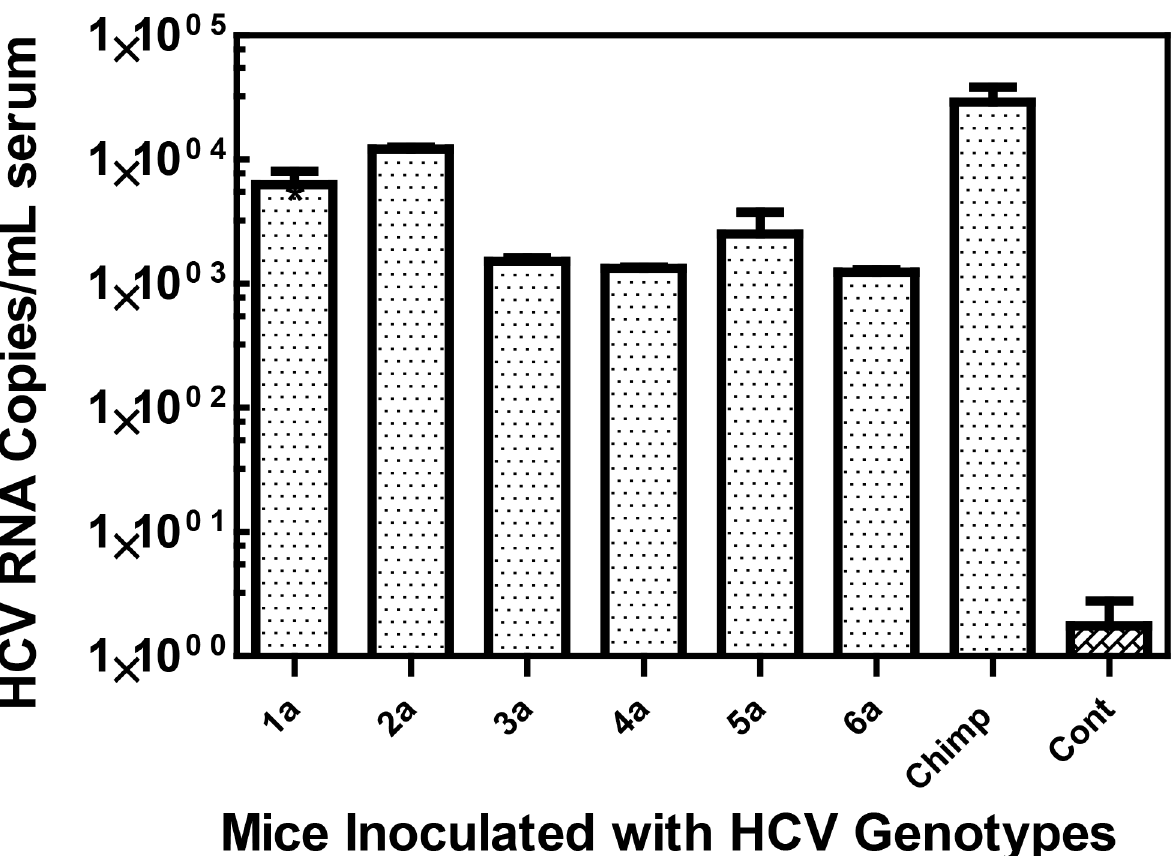
Figure 7. MUP-uPA/SCID/Bg mice infected with different HCV genotypes. The HCV RNA levels were measured by qRT-PCR on the serum of mice inoculated with various HCV genotypes